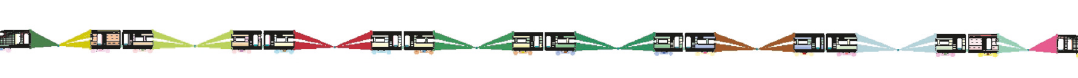
Figure 4: The structural model of the whole